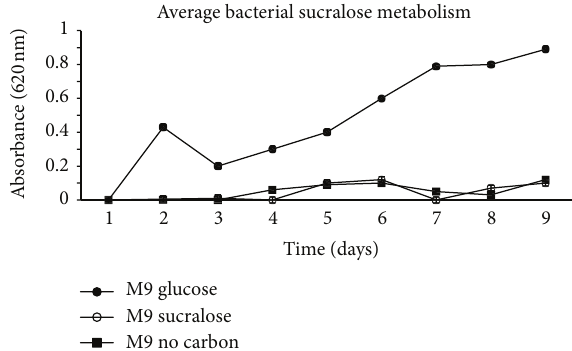
Figure 1: A composite growth curve depicting average bacterial growth with various carbon sources of the 6 isolates. M9 medium containing glucose as the only carbon source serves as a positive control, M9 medium containing only sucralose as a carbon source was the experimental group, and M9 medium containing no carbon sourceservesasa“starvationdiet”ornegativecontrol.Thiswasdone to indicate the presence, if any, of sucralose metabolism.